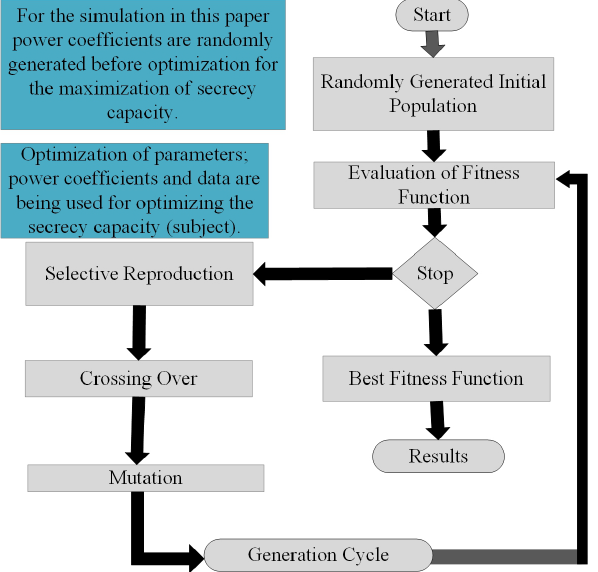
Figure 3. Flow chart description of genetic algorithm based